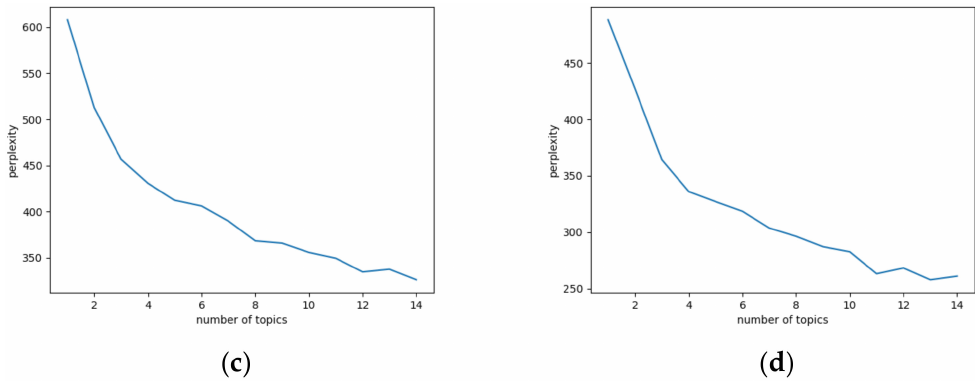
Figure 3. Perplexity graphs. ( a ) Incubation period; ( b ) explosion period; ( c ) recession period; ( d ) stabilization